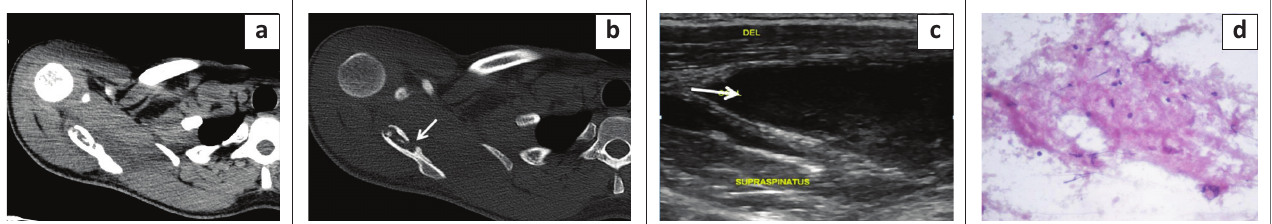
FIGURE 3: A 32-year-old male with swelling over the right shoulder region. Axial computed tomography images (a, b) show bony destruction of the right acromion process (white arrow) with an adjacent bulky subscapularis muscle. Subsequent ultrasound image (c) shows a hypo-echoic collection in between subscapularis and deltoid muscles. Fine needle aspirate (d) from an associated enlarged axillary lymph node shows caseous necrosis seen as acellular debris against a pauci-cellular background (Papanicolaou stain x 400).